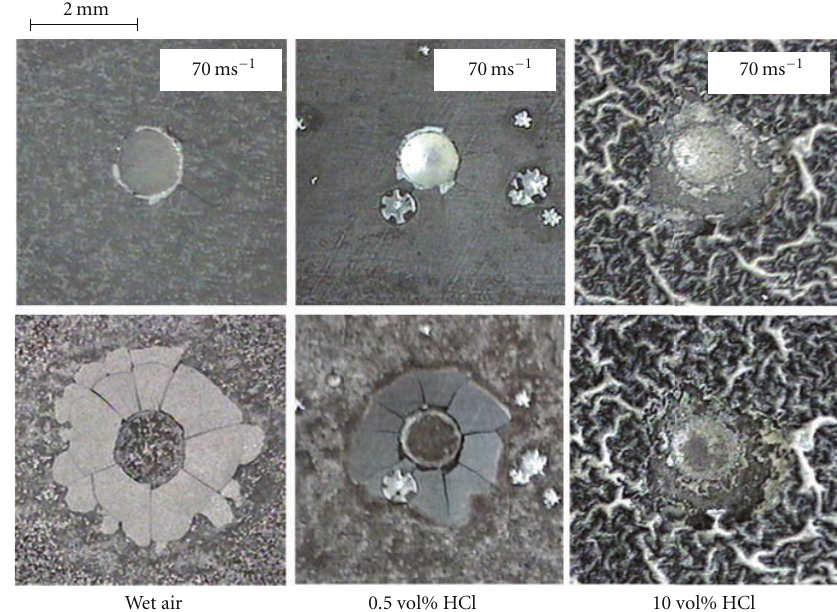
Figure 3: Appearances of oxide films formed on mild steel after the impact of a glass bead at 873K (upper photographs) and at about 15 hours after the impact (lower photographs).